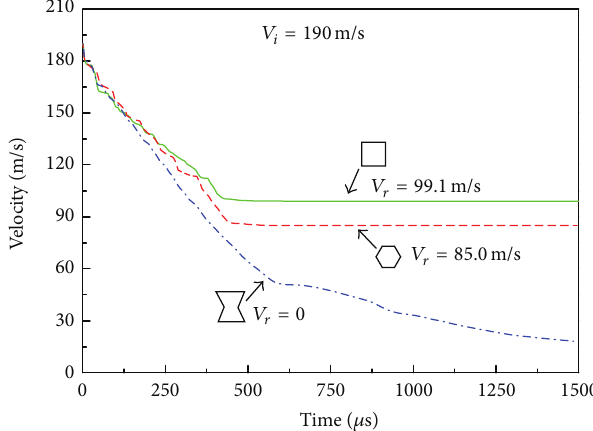
Figure11:Timehistoryofthetransientvelocityoftheprojectilewith = 190 m/s. Here 𝑉 𝑉 𝑖 𝑟 is the residual